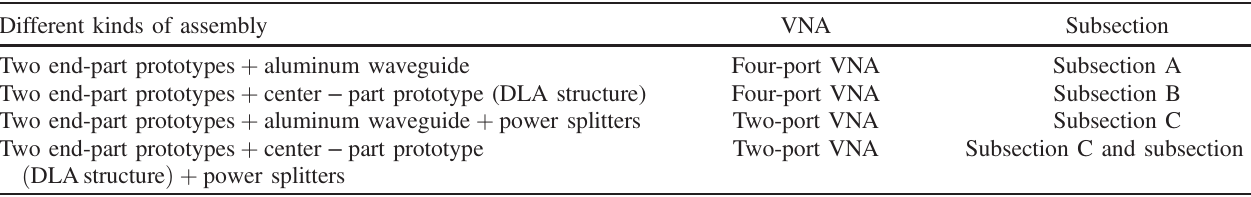
TABLE II. Different kinds of assembly for measurement. Different kinds of assembly